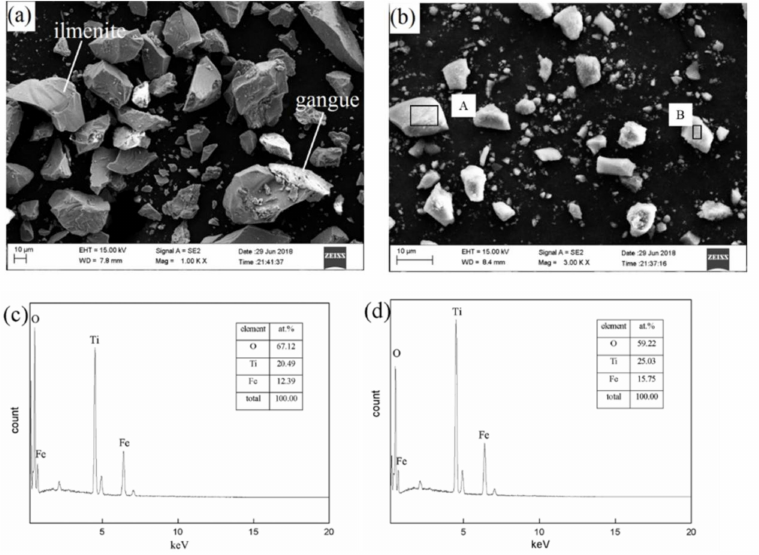
Figure 2. Microstructure of natural ilmenite and synthesis pseudorutile powder for ( a ) ilmenite; ( b ) synthesis pseudorutile powder; ( c ) SEM-EDS of point A in ( b ); ( d ) SEM-EDS of point B in ( b